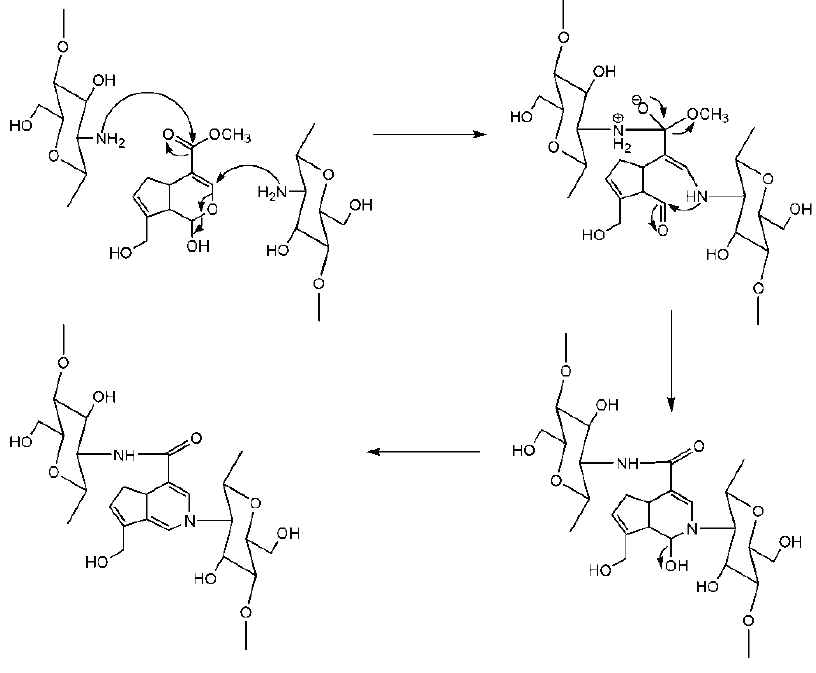
Figure 6. Cross-linking mechanism of chitosan and